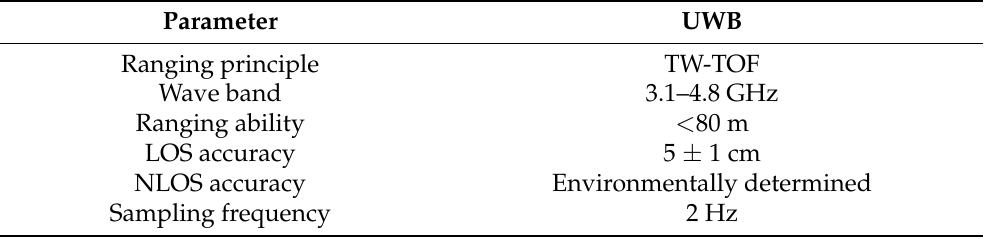
Table 4. Specifications of the UWB